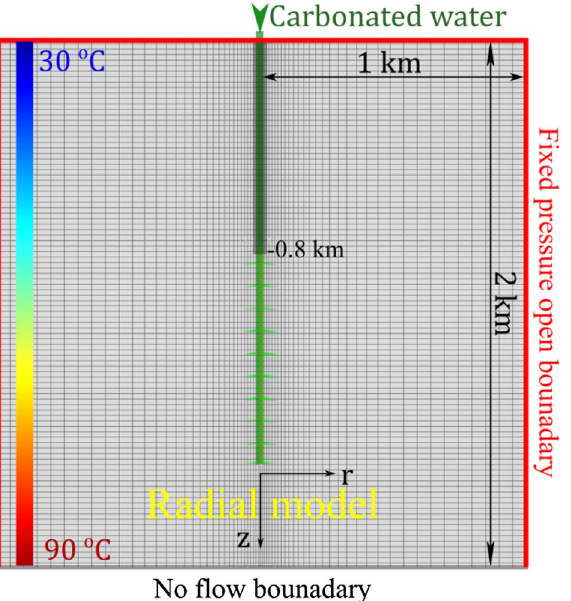
Figure 1. A schematic of the radial simulation domain considered in this study, including boundary conditions, injection zone, and the temperature gradient for the reference system. The plot background shows the numerical domain with 20 m blocks in the z direction and varying grid size in the radial direction. The finest grid blocks in the radial direction are 5 m, near the well, increasing to 50 m further away from the well.